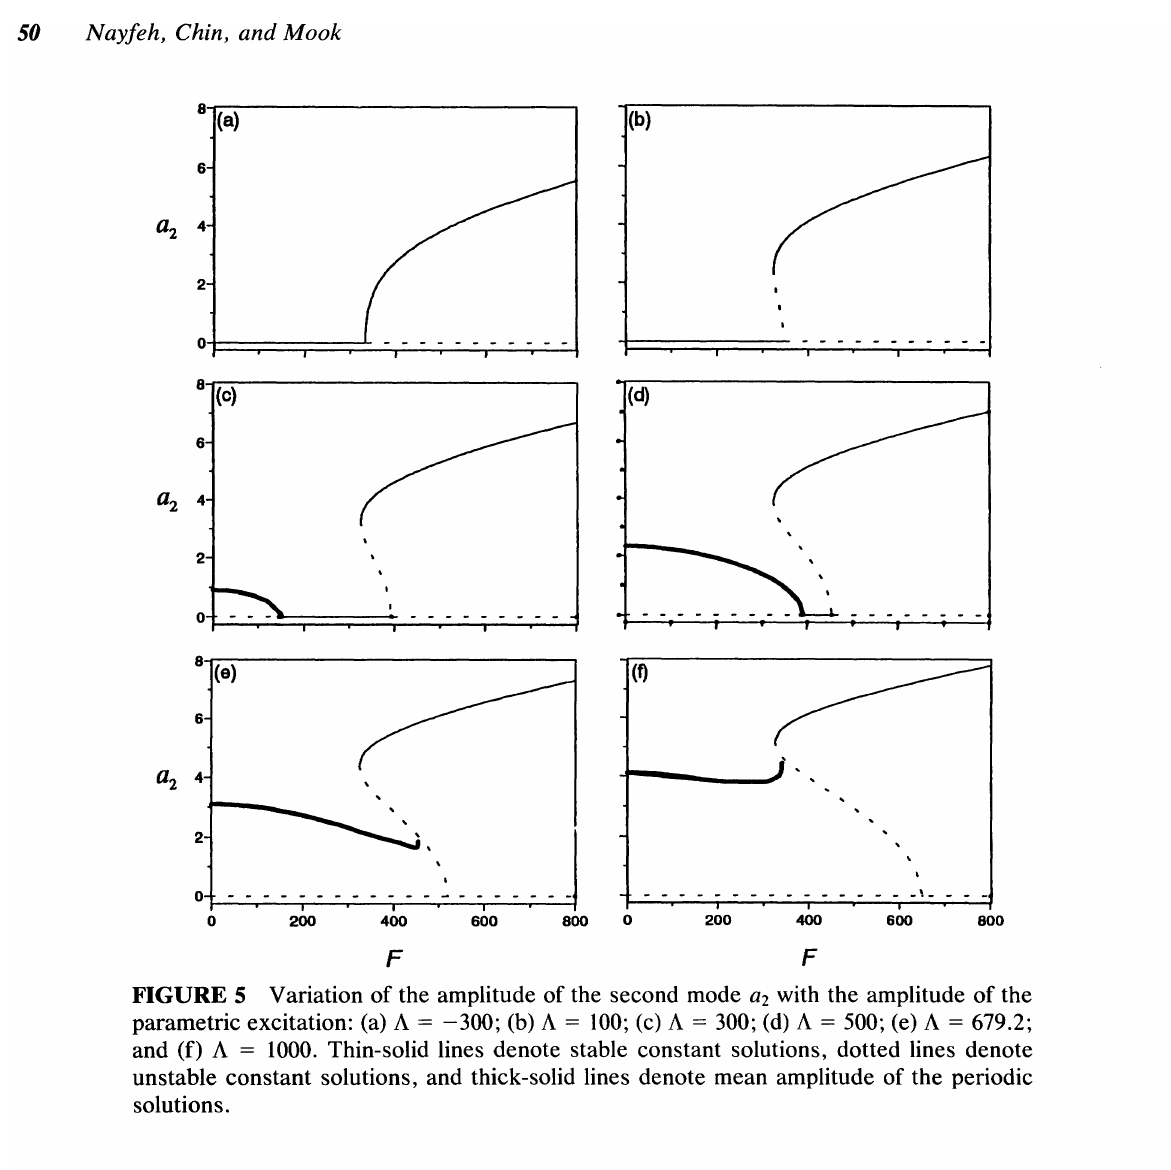
FIGURE 5 Variation of the amplitude of the second mode a2 with the amplitude of the parametric excitation: (a) A = -300; (b) A = 100; (c) A = 300; (d) A = 500; (e) A = 679.2; and (f) A = 1000. Thin-solid lines denote stable constant solutions, dotted lines denote unstable constant solutions, and thick-solid lines denote mean amplitude of the periodic